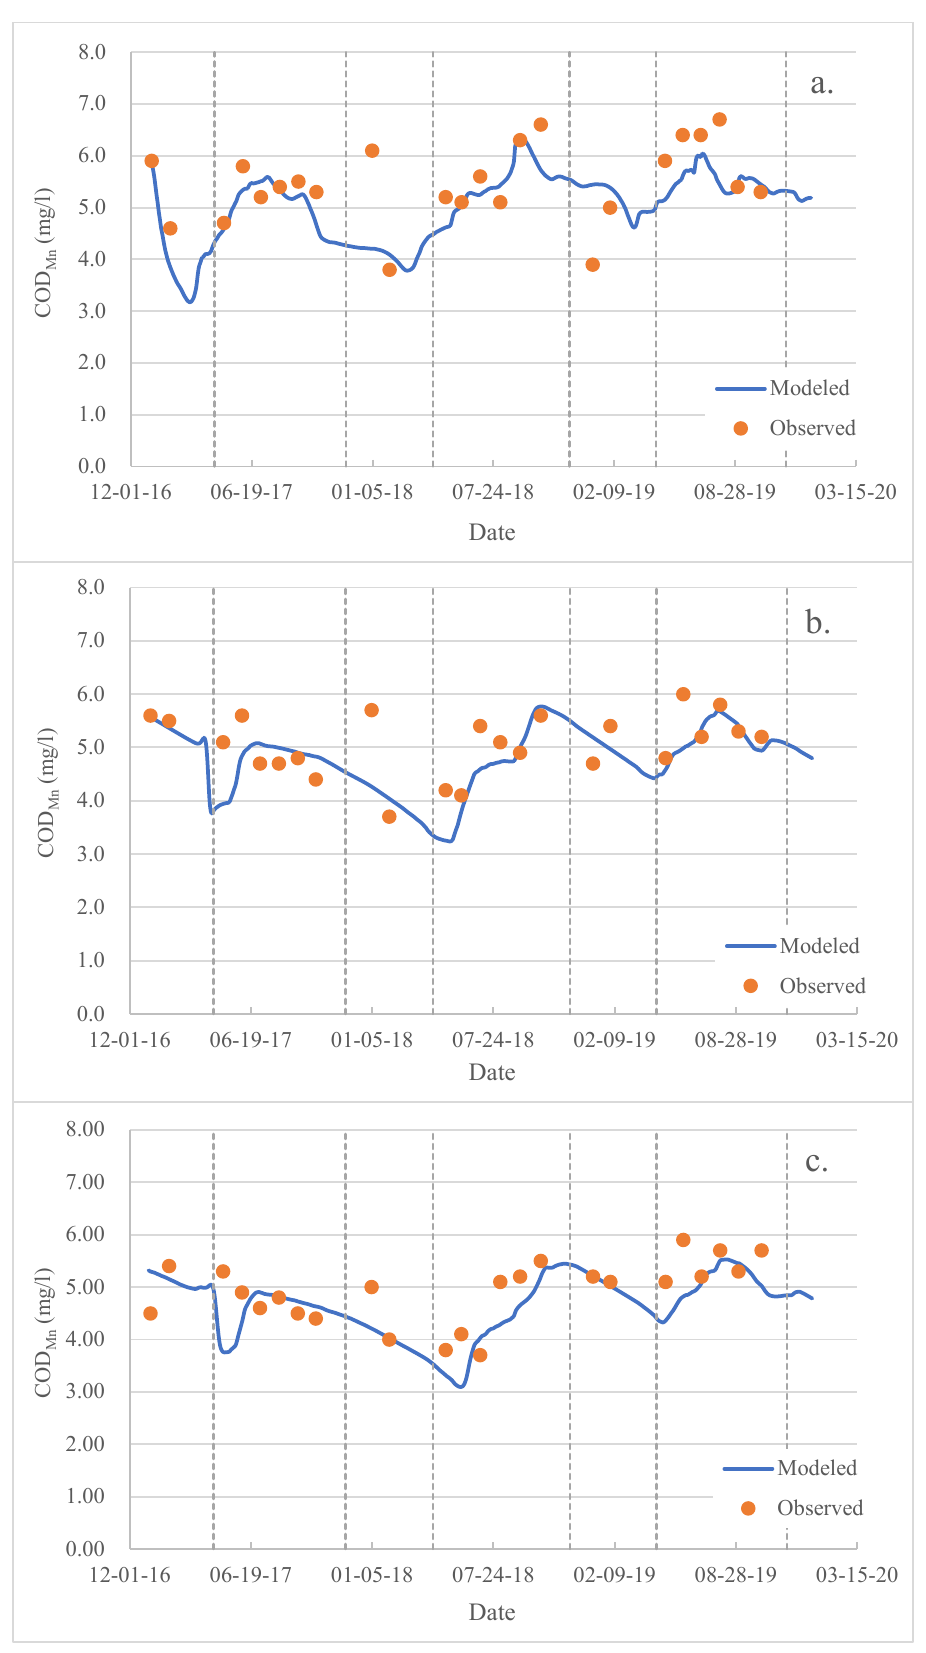
Figure 6. Comparison of the observed and simulated values of COD Mn at: ( a ) LHLZ sampling site; ( b ) DST sampling site; ( c ) GSC sampling site.